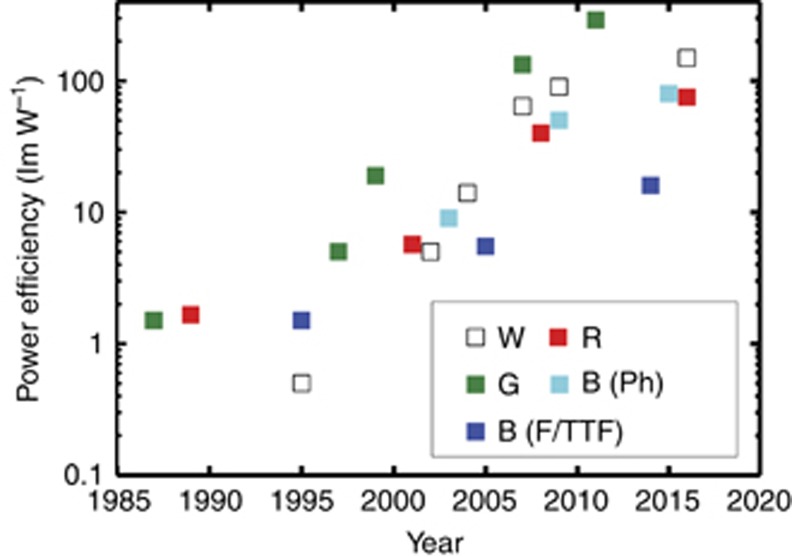
Power efficiency of white, red, green and phosphorescent blue and fluorescent/TTF blue OLEDs over time. Data are compiled from Refs. 41, 45, 114, 115, 116, 117, 118, 119, 120, 121, 122, 123, 124, 125, 126, 127, 128, 129, 130, 131, 132, 133.